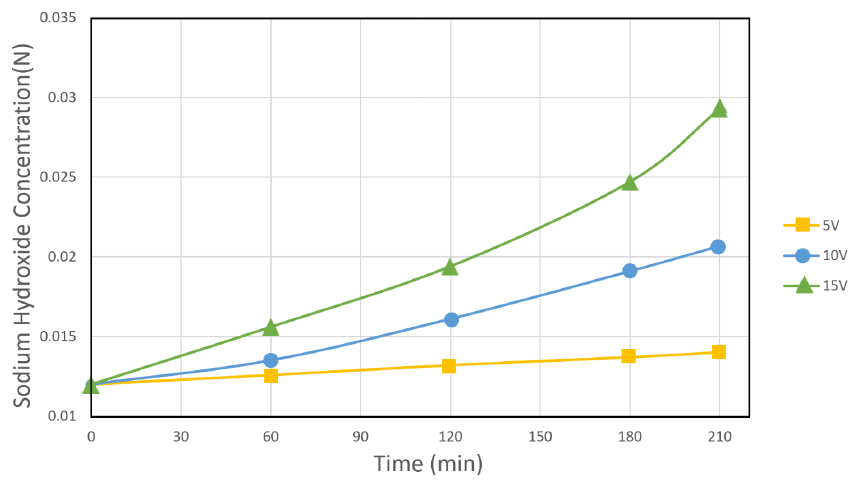
Figure 10. Sodium hydroxide concentration at various electric potential as a function of time.